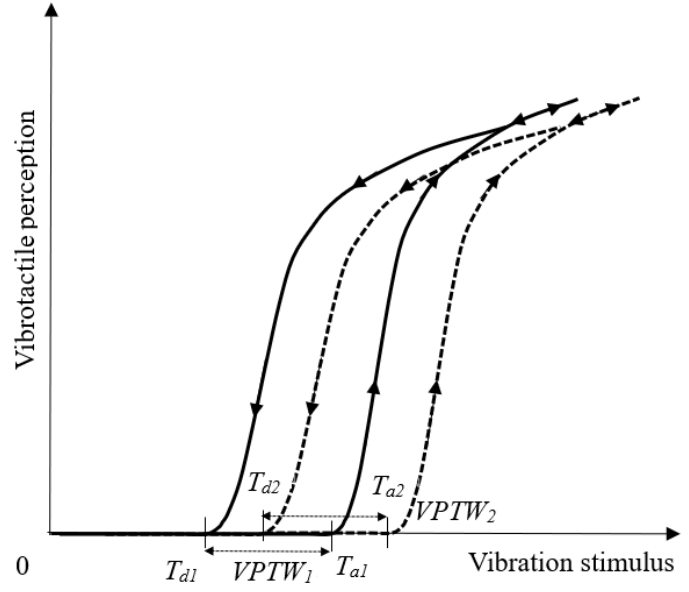
Figure 3. Schematic illustration of the vibrotactile perception model in response to vibrational stimulus, taking hysteresis characteristics into account. T a 1 and T a 2 denote ascending thresholds at conditions 1 and 2, respectively. T d 1 and T d 2 denote descending thresholds at conditions 1 and 2, respectively.